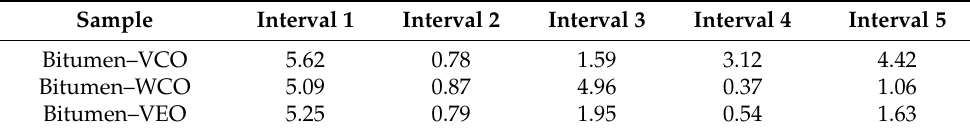
Table 5. Results of | R c | values in µ m/min for each interval and rejuvenated bitumen. Sample Interval 1 Interval 2 Interval 3 Interval 4 Interval 5 Bitumen–VCO 5.62 0.78